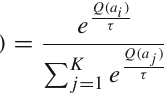
mann strategy [41] softens the probability of action sampling p ( a i ) according to the corresponding value function, i.e., the probability of a non-greedy action being selected is propor- tional to its corresponding action value function, which is calculated as shown in Eq.